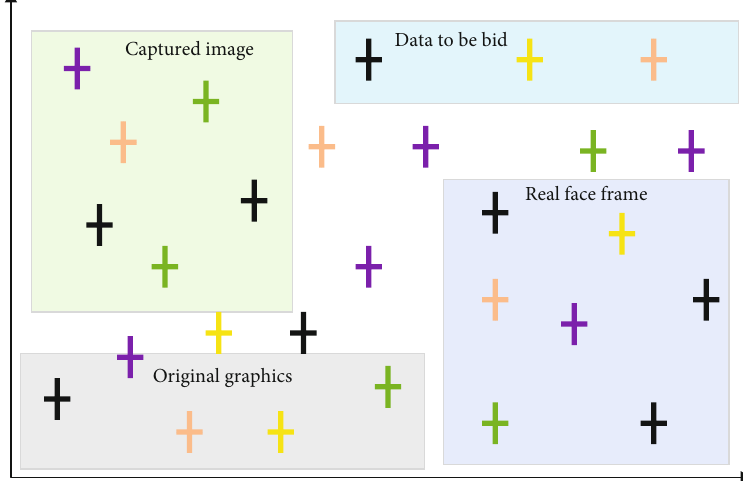
Figure 3: Label normalization of the boundaries of the character recognition